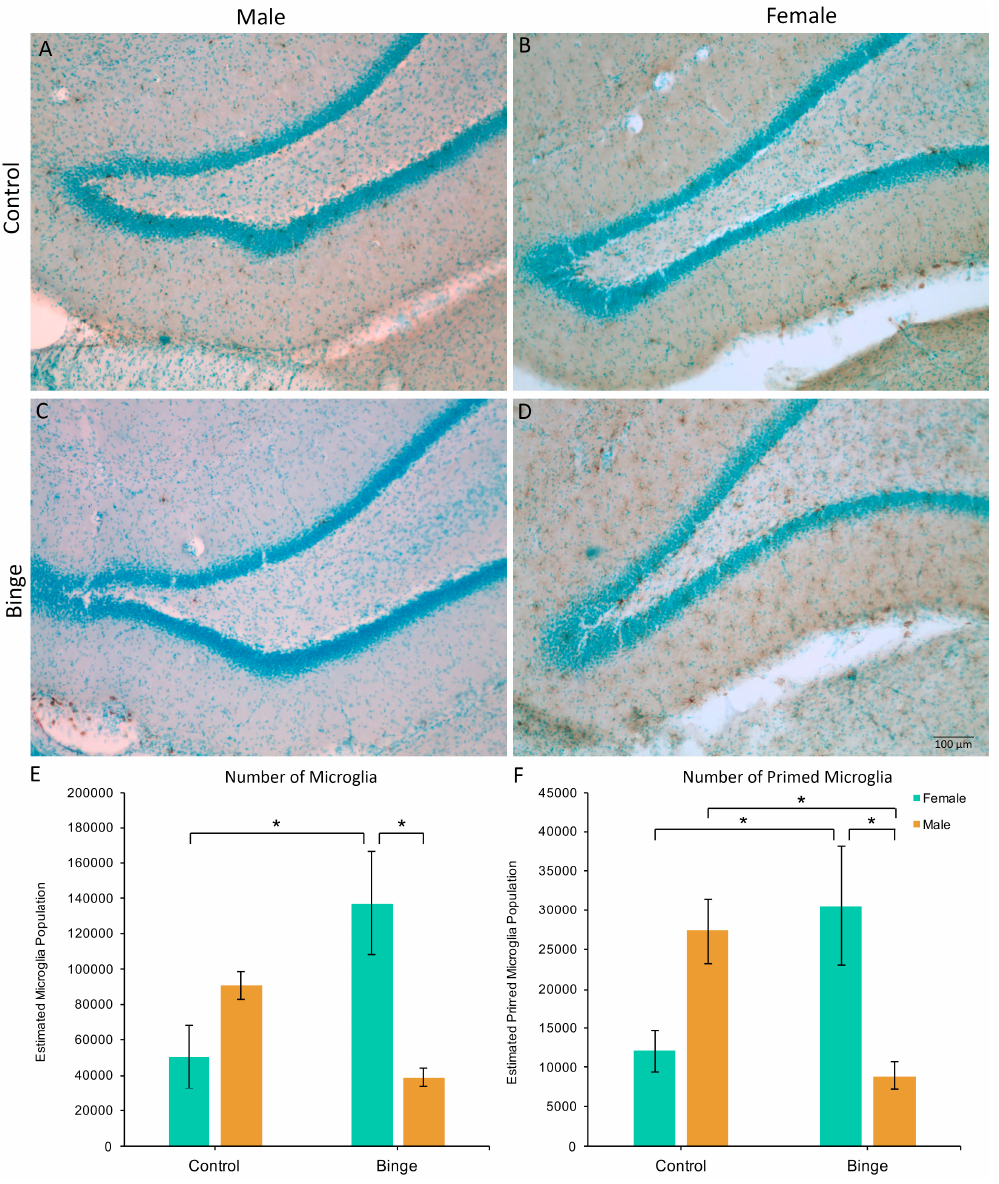
Figure 3. The effects of binge alcohol and exercise on microglia in the hippocampus of males ( A , C ) and females ( B , D ). Binge alcohol increased the number of microglia in females compared to female controls and binged males ( E ). Binge alcohol increased the number of morphologically primed microglia in females, but decreased it in males ( F ). * p < 0.05.